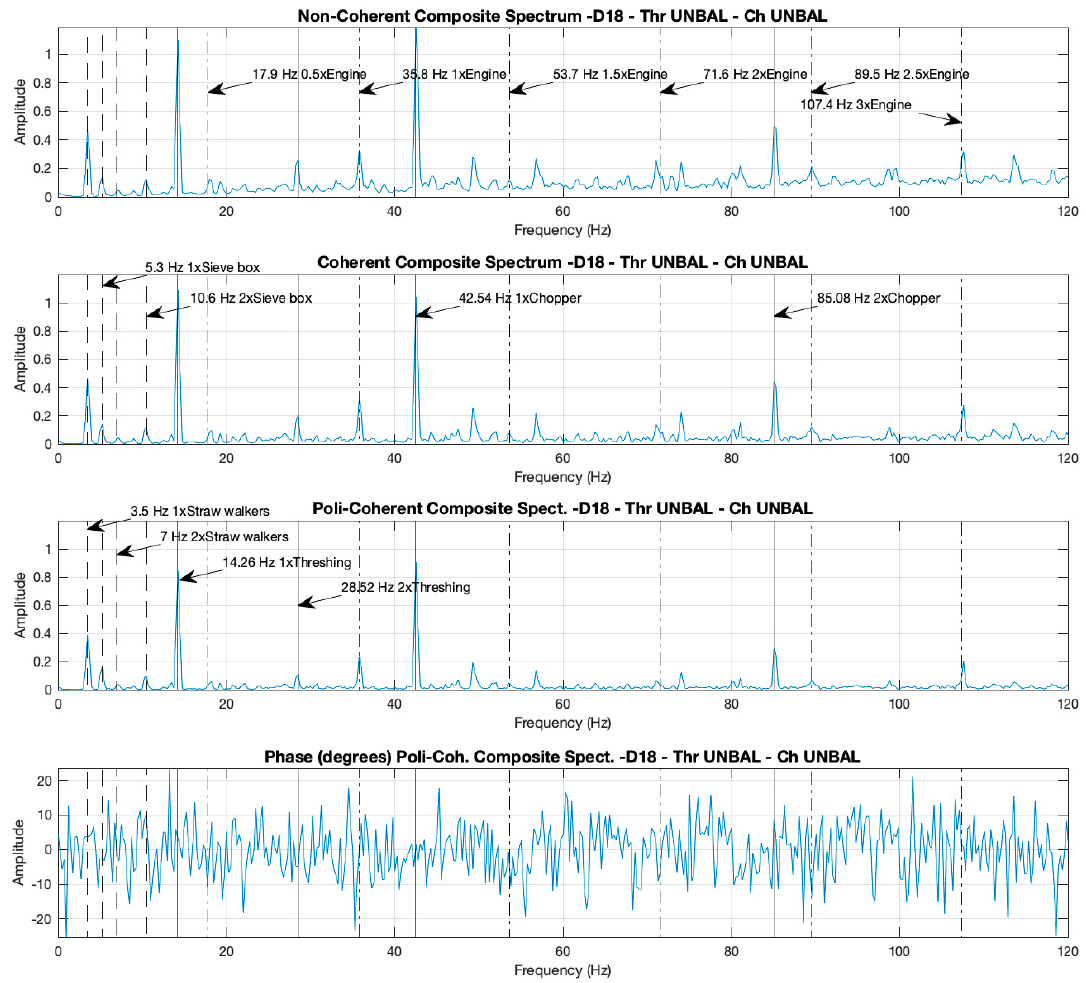
Figure 5. Case D18. Non-coherent, coherent, and poly-coherent composite spectra with the thresher and the chopper both activated and unbalanced, with the motor at maximum RPM.